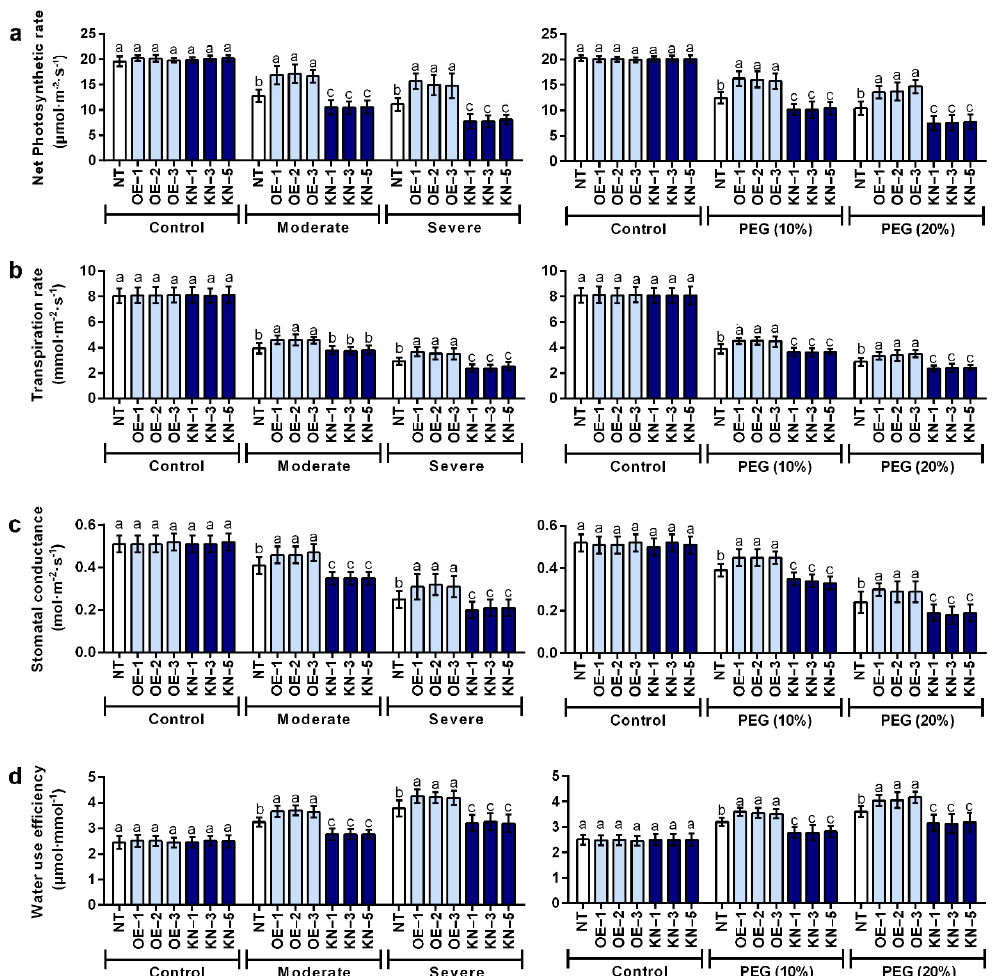
Figure 5. StCDPK28 overexpression in potato enhances photosynthesis, transpiration, stomatal conductance and water use efficiency in response to water deficiency and osmotic stress. After the plants were cultivated under water deficiency and osmotic stress for 24 h, ( a ) net photosynthetic rate, ( b ) transpiration rate, ( c ) stomatal conductance, and ( d ) water use efficiency were evaluated. Data are presented as the means ± standard deviation of nine replicates. The letters indicate significant difference according to one-way ANOVA corrected by Dunnett ( p < 0.05).